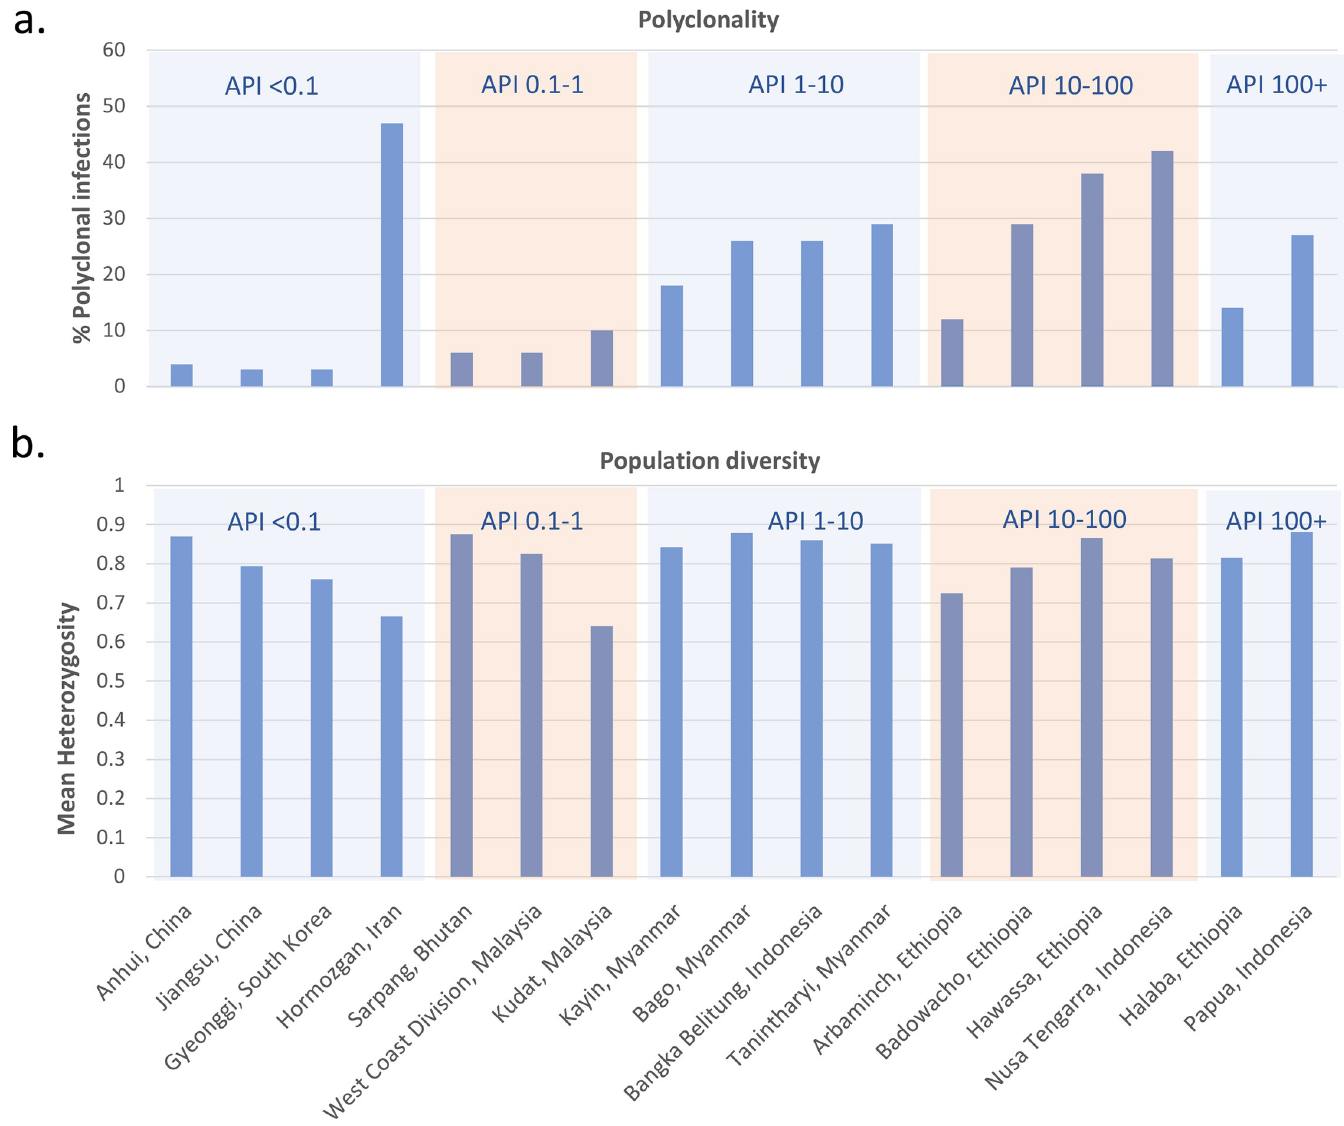
Fig 2. Trends in P . vivax polyclonality and population diversity across endemic settings. The data were derived from published, open-access online vivaxGEN-MS platform [113]. Sites represent first- or second-level administrative divisions and include areas with a minimum of 15 clinical isolates. Measures were restricted to 3 microsatellite markers: Pvmsp1f3, PvMS16, and Pv3.27 [114]. Polyclonality reflects the percentage of P . vivax infections with 1 or more markers exhibiting more than 1 allele. The population diversity was approximated using the mean expected heterozygosity. Approximations of the API per 1,000 population were derived from the original publications [16,18,41,91,115–119].The results demonstrate a general trend of increasing polyclonality with increasing API, with several deviations potentially reflecting factors such as imported cases. In contrast, population-level diversity remains high across endemic settings, potentially reflecting sustained diversity from the liver-stage reservoir. API, annual parasite